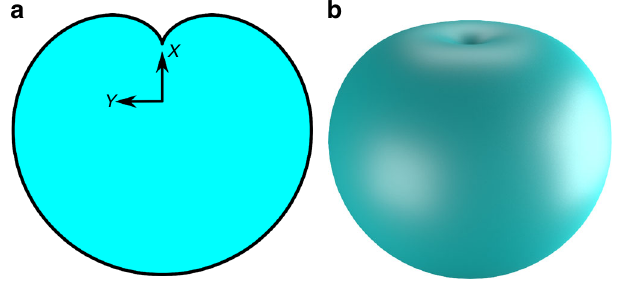
Fig. 8 The cardioid surface. The cardioid surface is constructed by revolving the planar cardioid curve. a shows the curve, b shows the complete